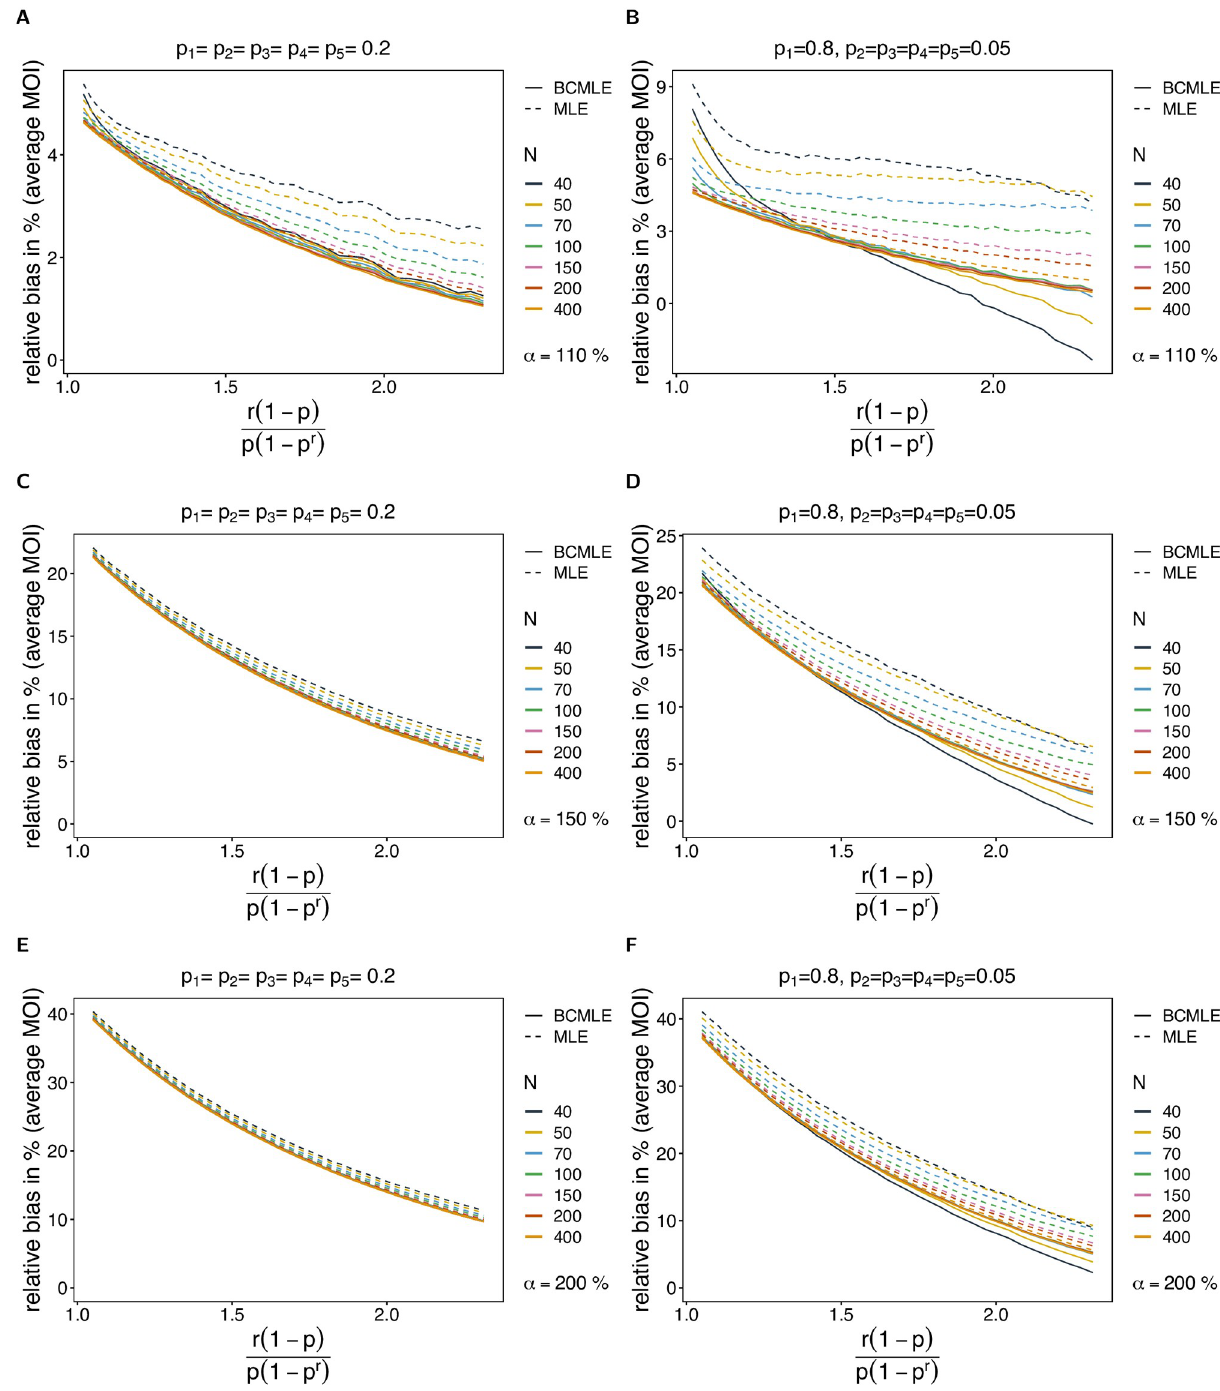
Fig 4. Robustness of MOI estimates against model violations. The figure shows the bias of the BCMLE ^ c ð bc Þ (solid lines) and MLE ^ c (dashed lines) in % as a function of the true parameter c ¼ r ð 1 (cid:0) p Þ . The datasets are generated from the conditional negative binomial model whereas the estimates are p ð 1 (cid:0) p r Þ derived from the conditional Poisson model. The panels in different rows correspond to different levels of overdispersion indicated by α . Panels on the left and right assume a different lineage-frequency distributions p shown at the top of each panel. Line colors correspond to a different sample sizes ( N ).